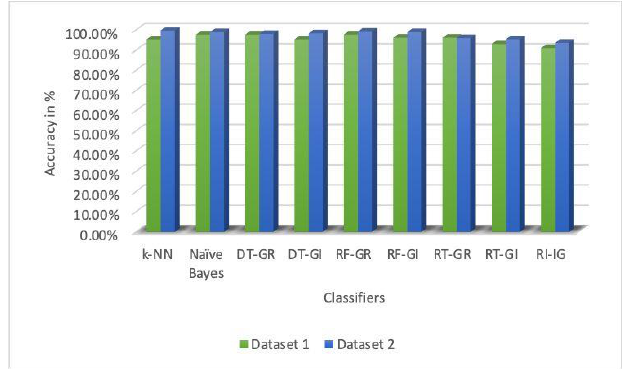
Fig. 2. Comparison in terms of accuracy of technical courses